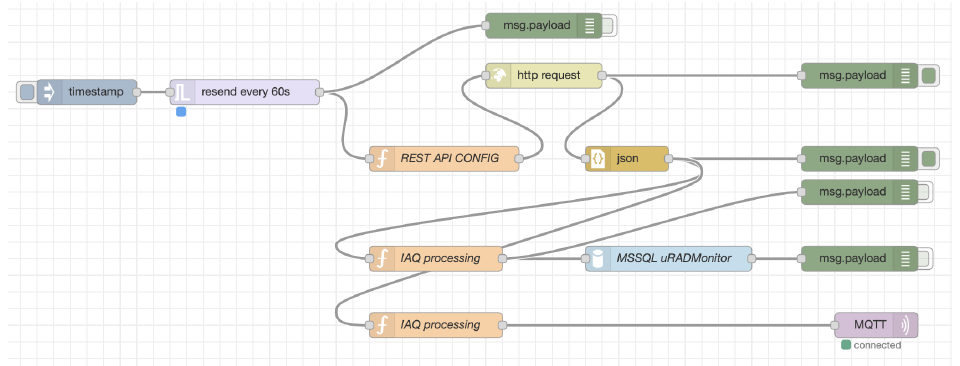
Figure 3. Node-red flows for data